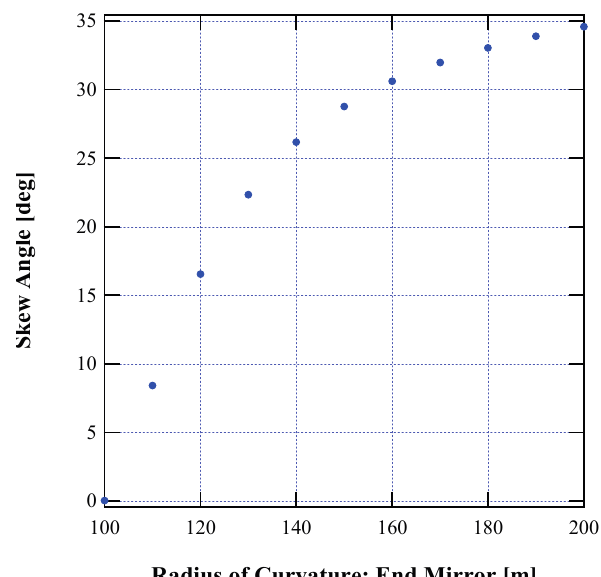
Figure 5. Skew angles of the transmitted beam intensity paraboloid